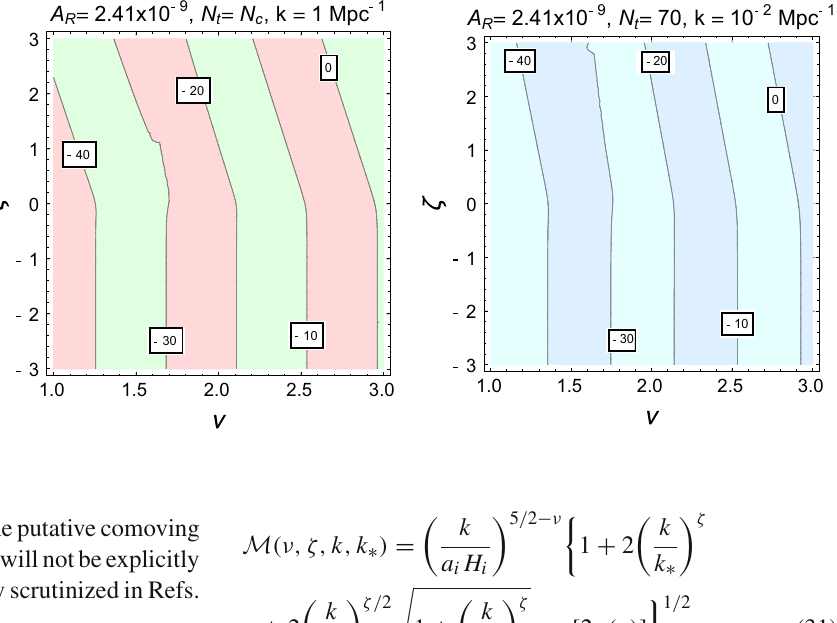
Fig. 1 The parameter space is described in the (ν,ζ) plane for two different values of the number of efolds and for two complementary comoving scales. The labels appearing on the various isospectral curves denote te common logarithm of √ P B ( k ,τ c ) expressed in